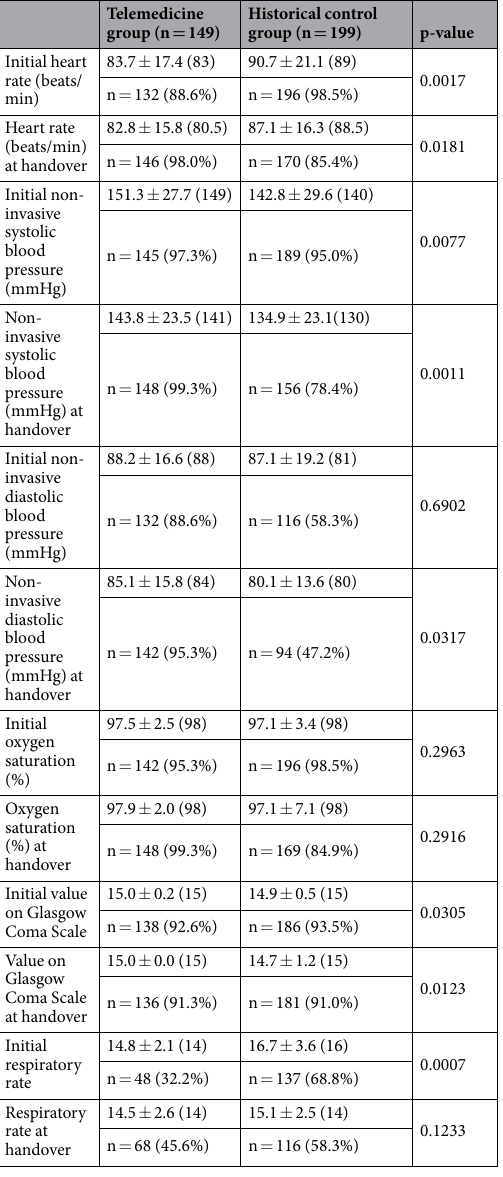
Table 3. Analgesia-related safety parameters before and after analgesic treatment at the time of handoff at the emergency department. Telemedical group versus control group. Parameters displayed as means ± standard deviation and medians in